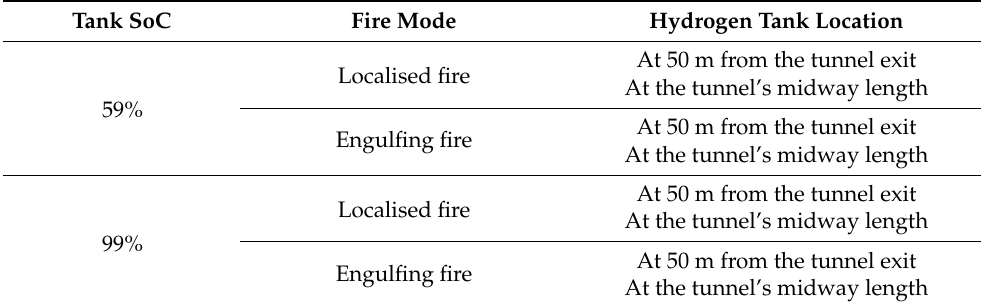
Table 4. Tank rupture events, which are used for building the F–N curve.